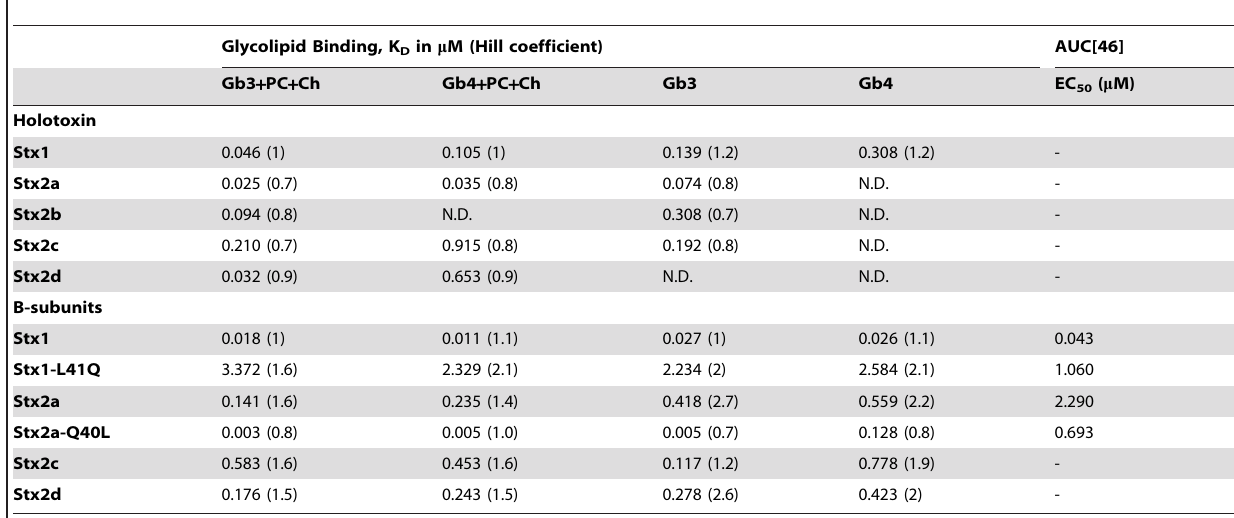
Table 4. EC 50 values (in), glycolipid binding dissociation constants for Stx holotoxin and B-subunits (N.D.: Not determined due to insignificant